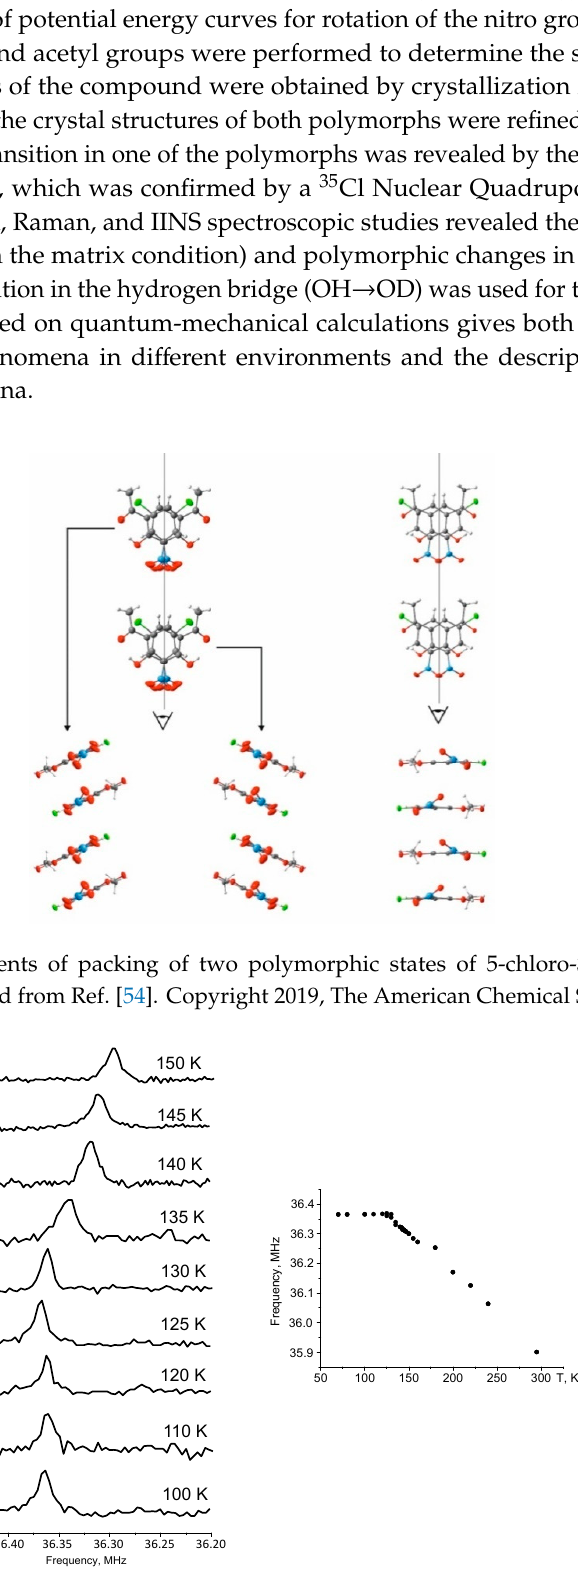
Figure 13. The 35 Cl Nuclear Quadrupole Resonance (NQR) spectra of 5-chloro-3-nitro-2-hydroxy-acetophenone and the plot of 35 Cl NQR resonance frequency as a function of temperature. Reprinted from Ref. [54]. Copyright 2019, The American Chemical Society.